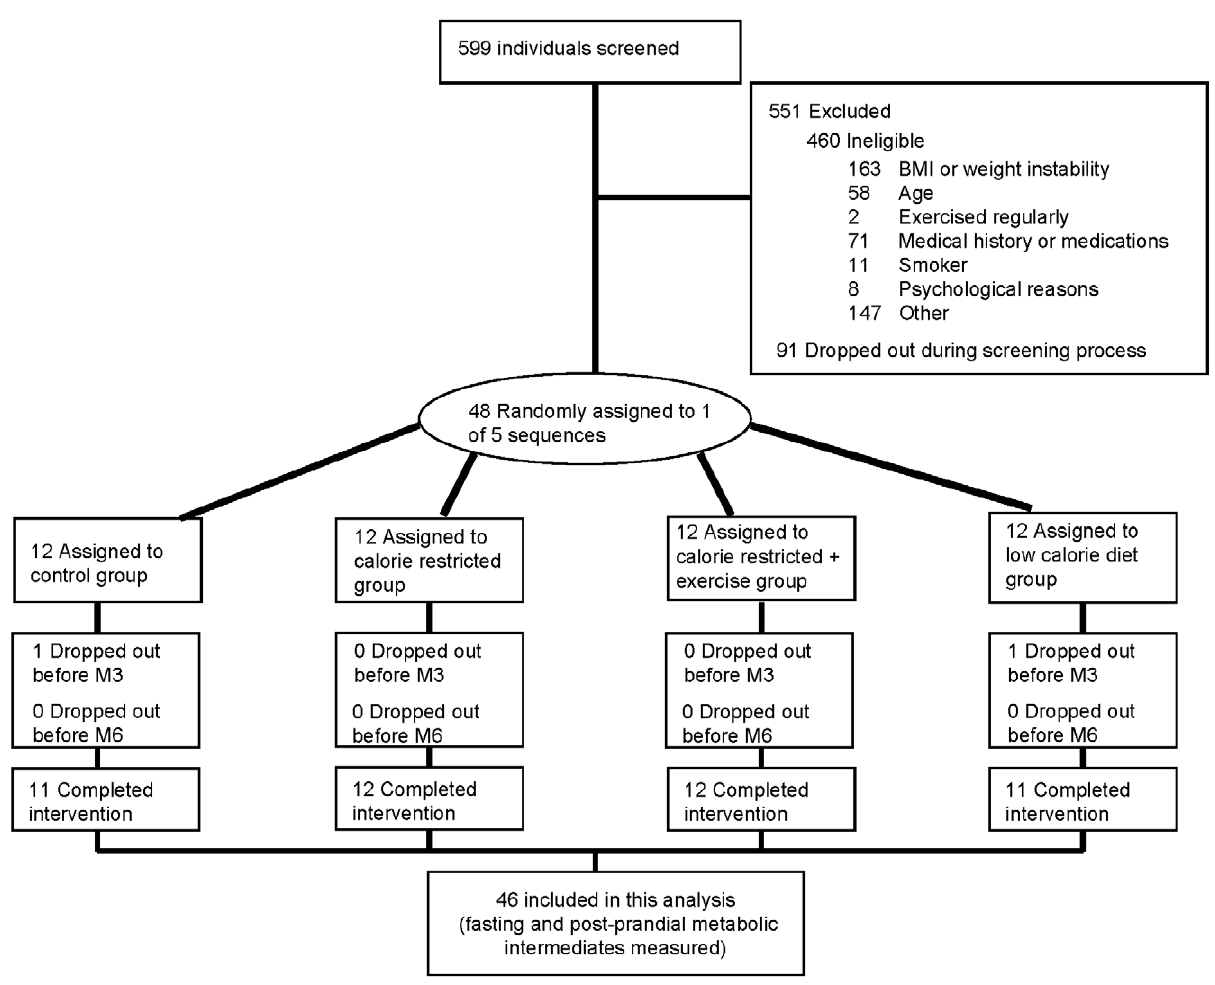
Figure 1. Flow of Participants through the CALERIE trial at Pennington Biomedical Research Center. This Figure has been published previously [10,25].